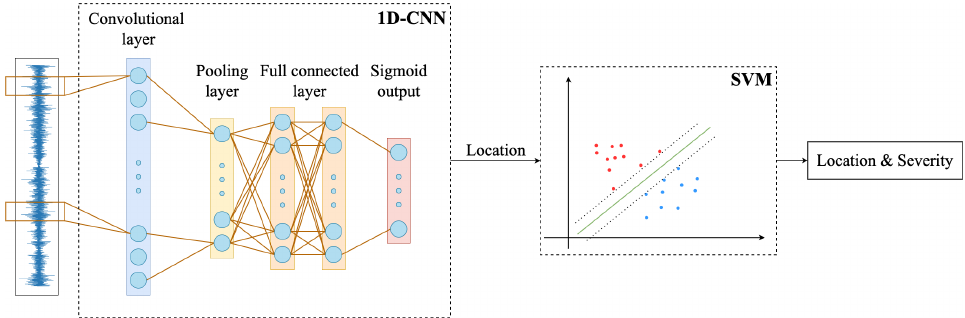
Figure 1. An overview of our proposed